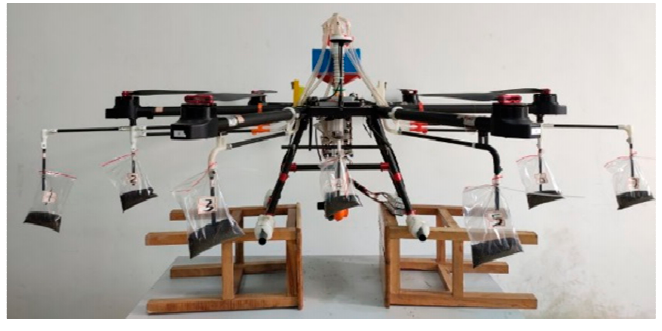
Figure 4. Static workbench test.